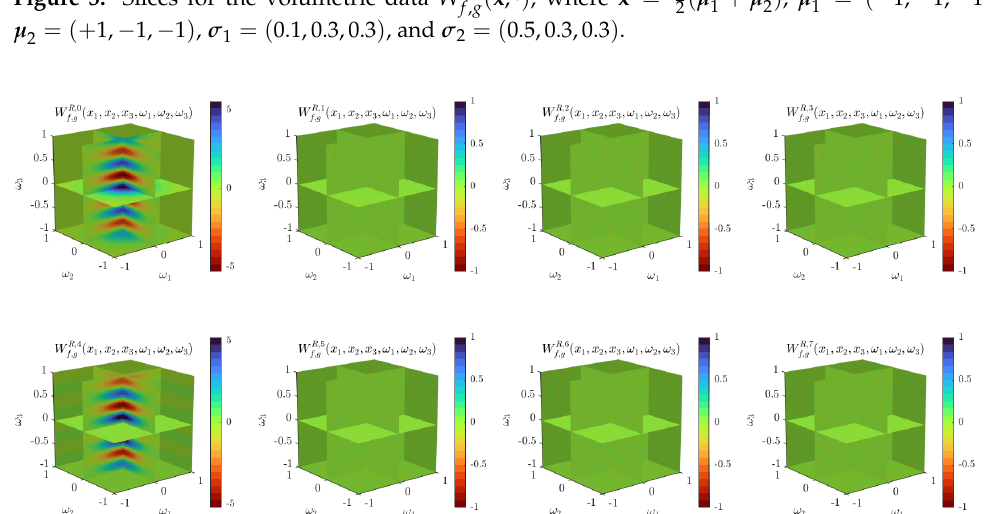
Figure 3. Slices for the volumetric data W R